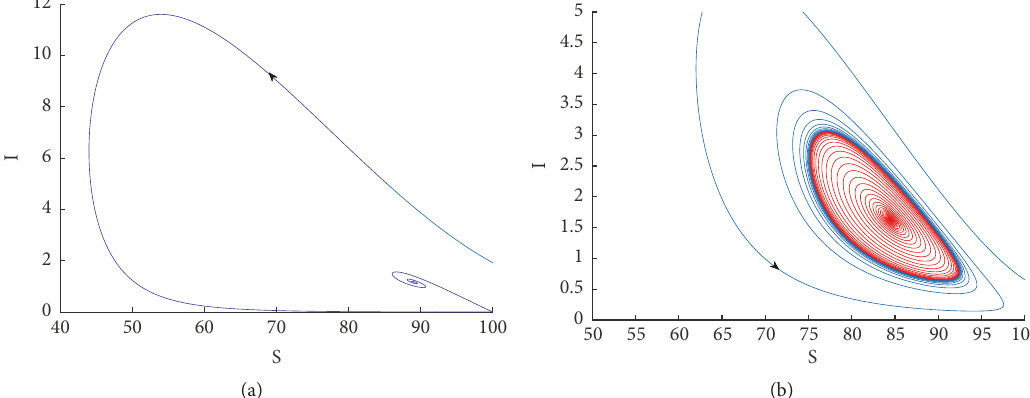
Figure 11: Phase portrait of the system near the BT point of codimension 3 when a supercritical Hopf bifurcation occurs. In (a), the endemic equilibrium is stable. In (b), the endemic equilibrium is unstable and there is a stable limit